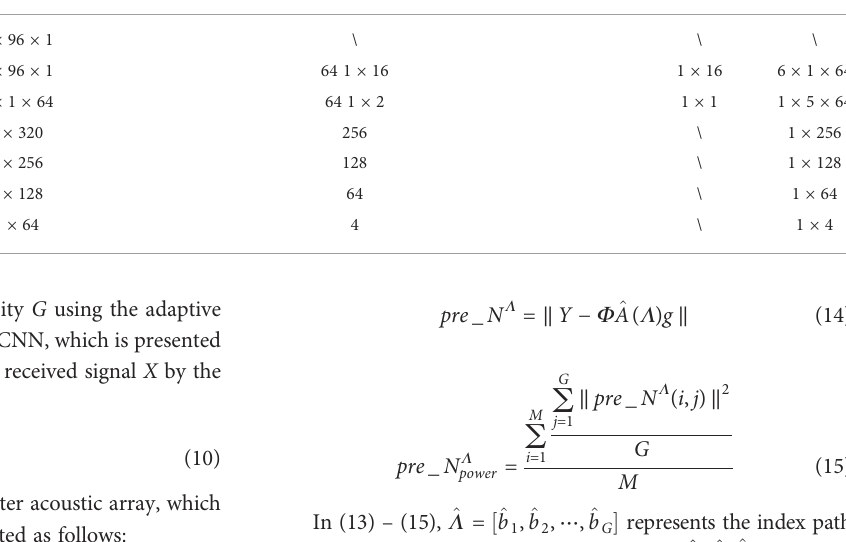
TABLE 1 The network parameters. Layer